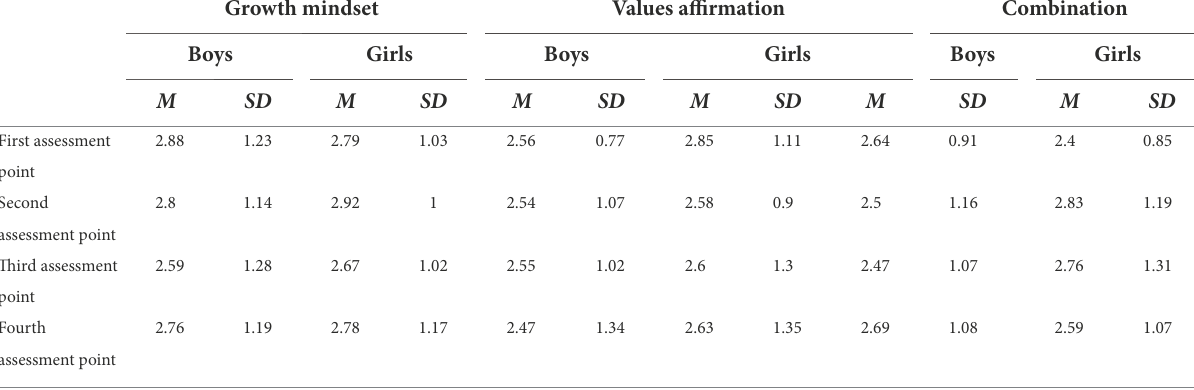
TABLE 3 Means and standard deviations of gender identification for all measurement points, split by gender and intervention method.